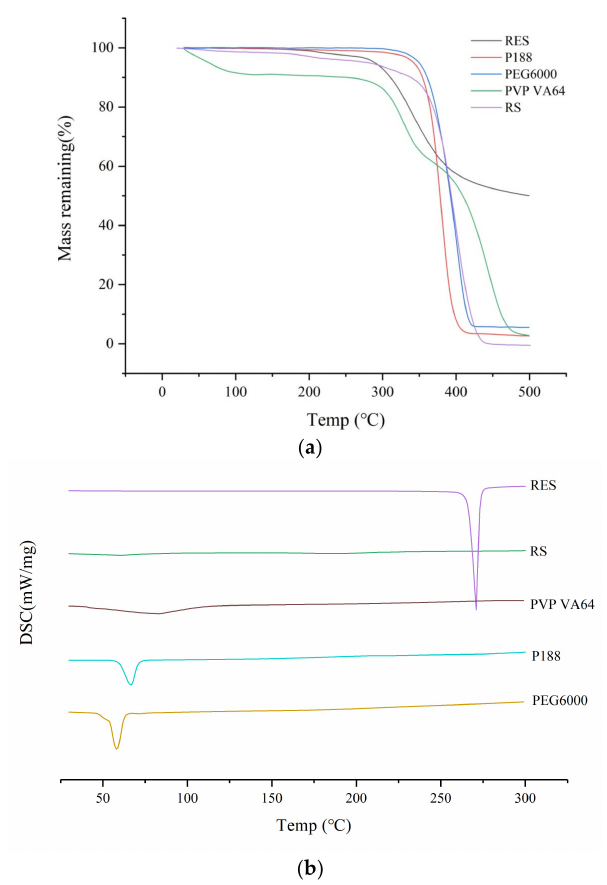
Figure 1. TGA diagram ( a ) and DSC diagram ( b ) of resveratrol and